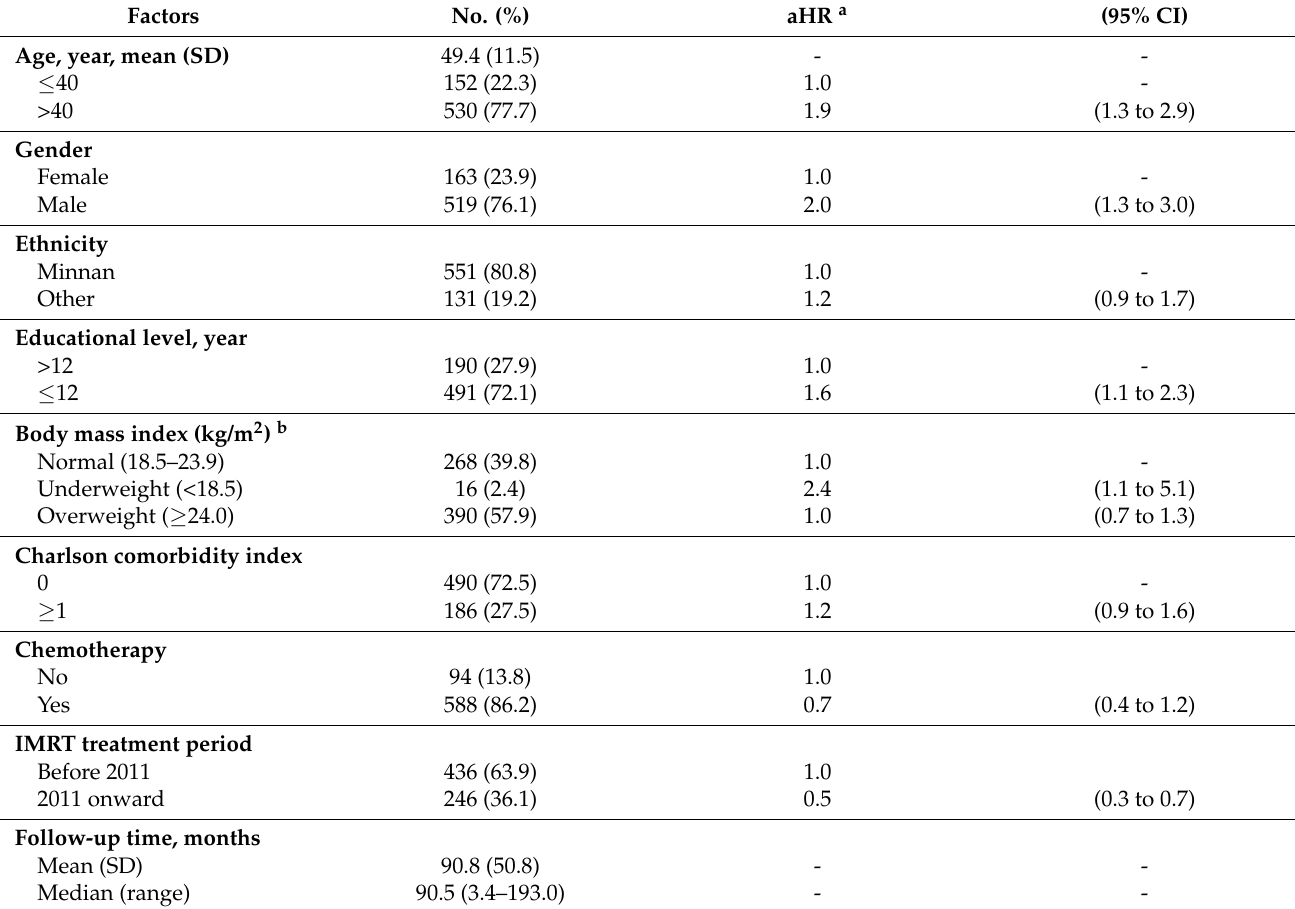
Table 1. Distributions and adjusted hazard ratios (aHR) of mortality for demographic and clinical factors in nasopharyngeal cancer patient cohort ( n = 682).